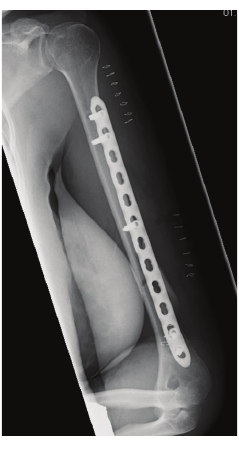
Figure 2: Postoperative radiograph shows the minimally invasive plate osteosynthesis and the skin staples.